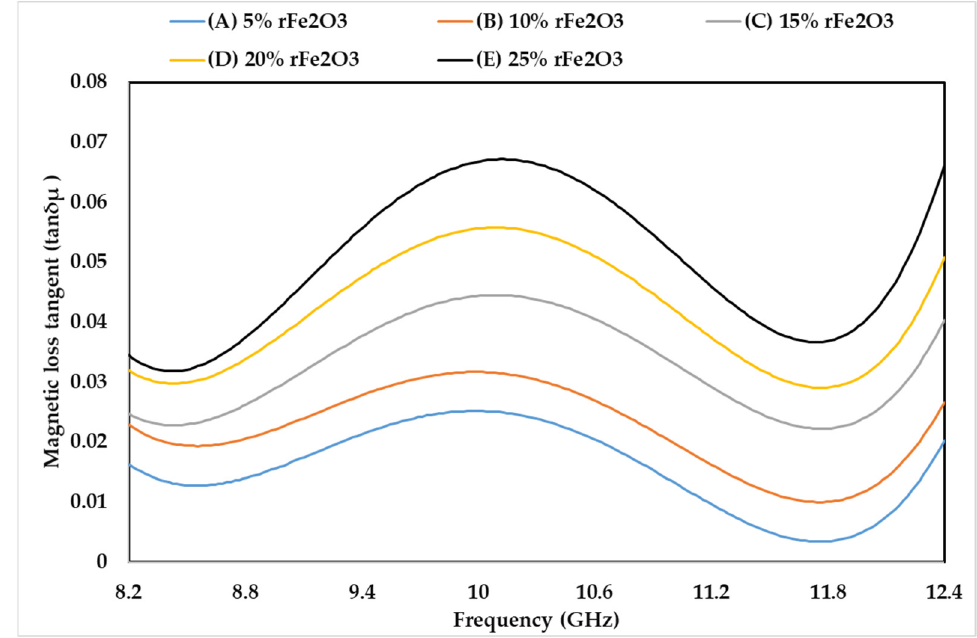
Figure 16. Variation in magnetic loss tangent of rFe 2 O 3 –PTFE nanocomposites.